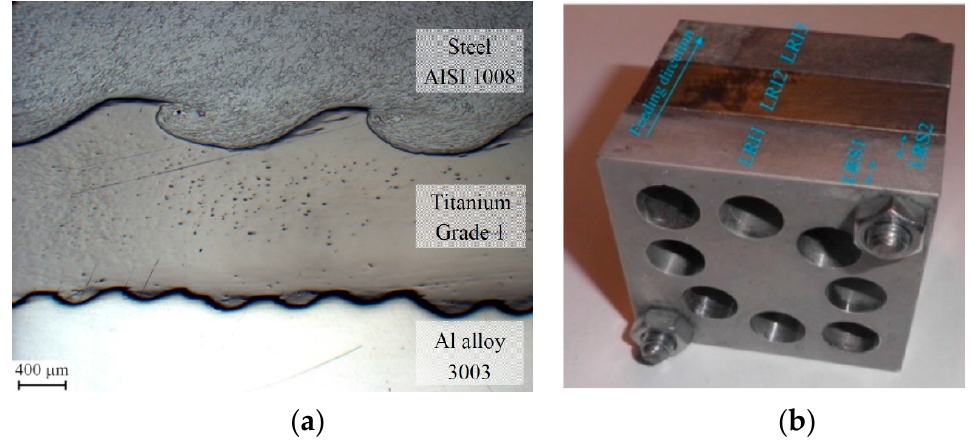
Figure 3. ( a ). Cross-section of an explosion-welded joint between a steel and an aluminium alloy with a titanium interlayer [51]; ( b ) Cutting Parameter Selection for Efficient and Sustainable Repair of Holes Made in Hybrid Mg–Ti–Mg Component Stacks by Dry Drilling Operations [16].